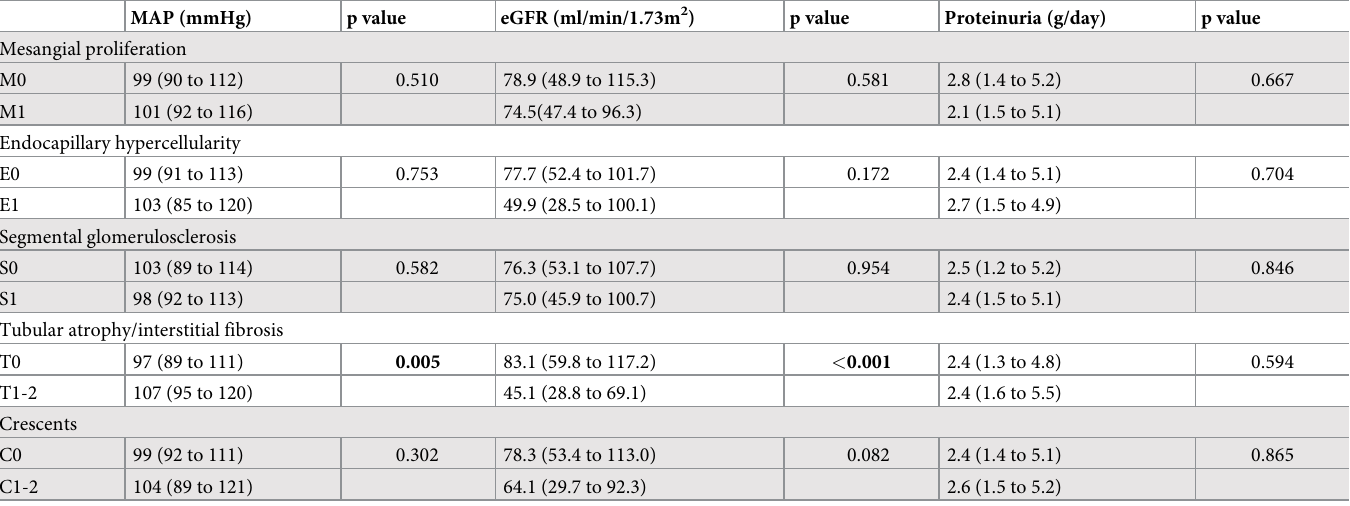
MAP: mean arterial pressure, eGFR: estimated glomerular filtration